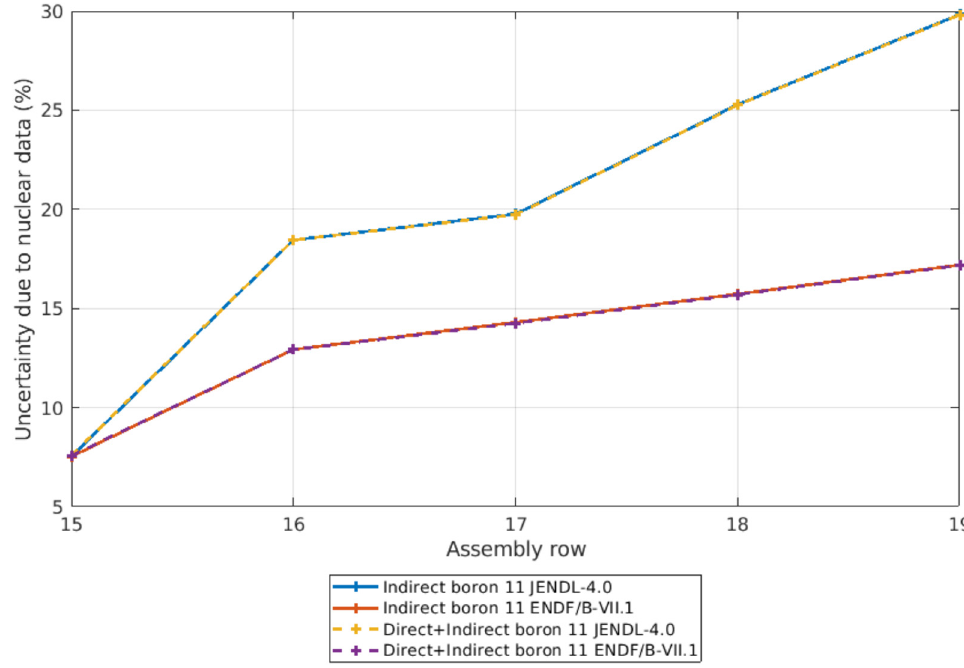
Fig. 32. Total uncertainty due to nuclear data on the production of alpha particles in the neutron shielding assemblies.